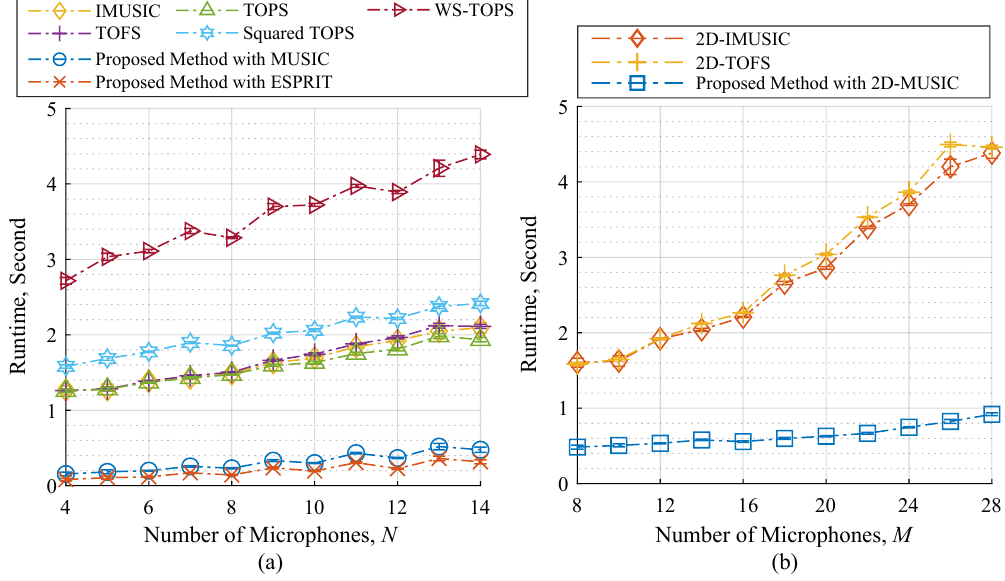
Figure 9. Computational complexities; ( a ) changing the number of microphone elements each subarray N , and ( b ) the number of microphone elements including all subarray M where the number of incident sources K =